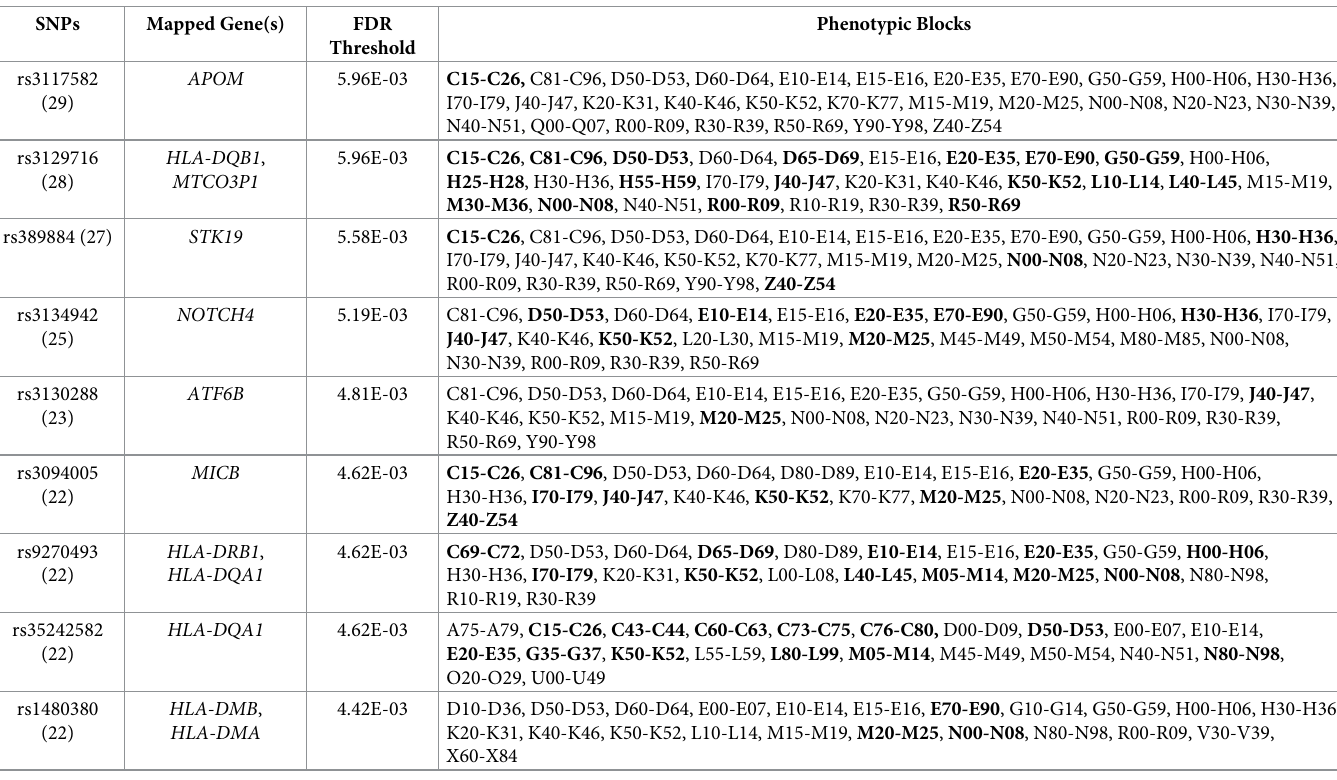
Table 3. The top nine SNPs that are associated with multiple phenotypic blocks identified by the HCLC-FC method based on the UK Biobank data. The information of the phenotypic blocks can be found at https://biobank.ndph.ox.ac.uk/showcase/field.cgi?id=41202. The bold-faced blocks indicate the associations with the correspond- ing SNP reported in the GWAS catalog. The number under the rs-number of SNP represents the total number of phenotypic blocks identified. FDR threshold is calculated at a nominal FDR level of